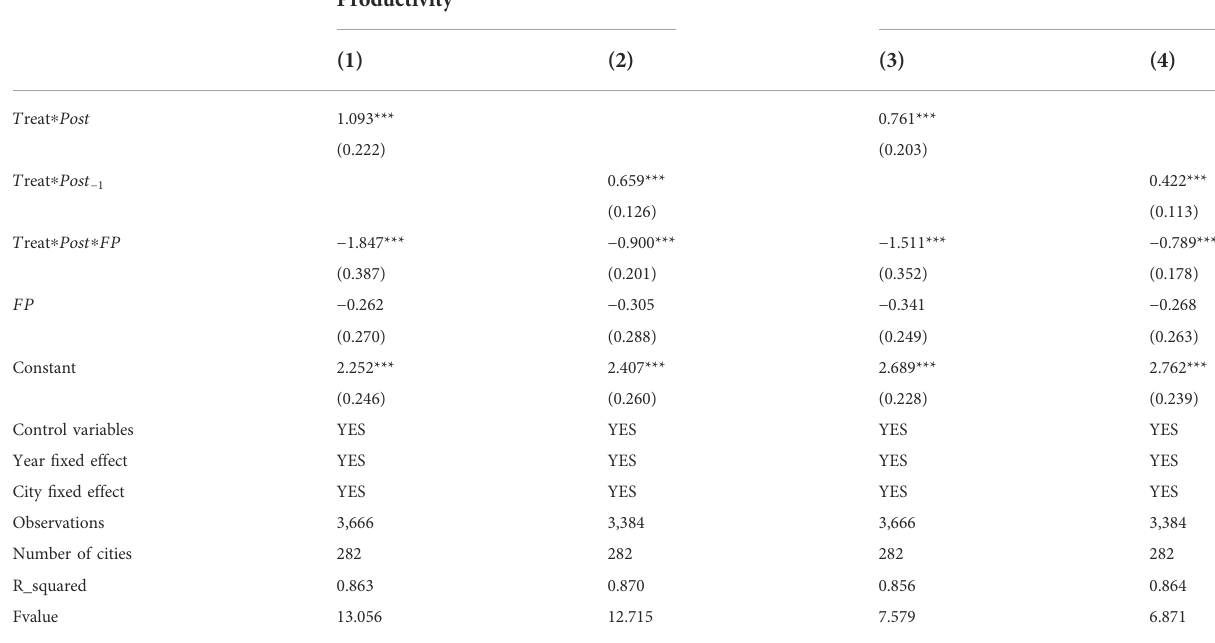
TABLE 5 Estimations after using the secondary industry and industrial carbon